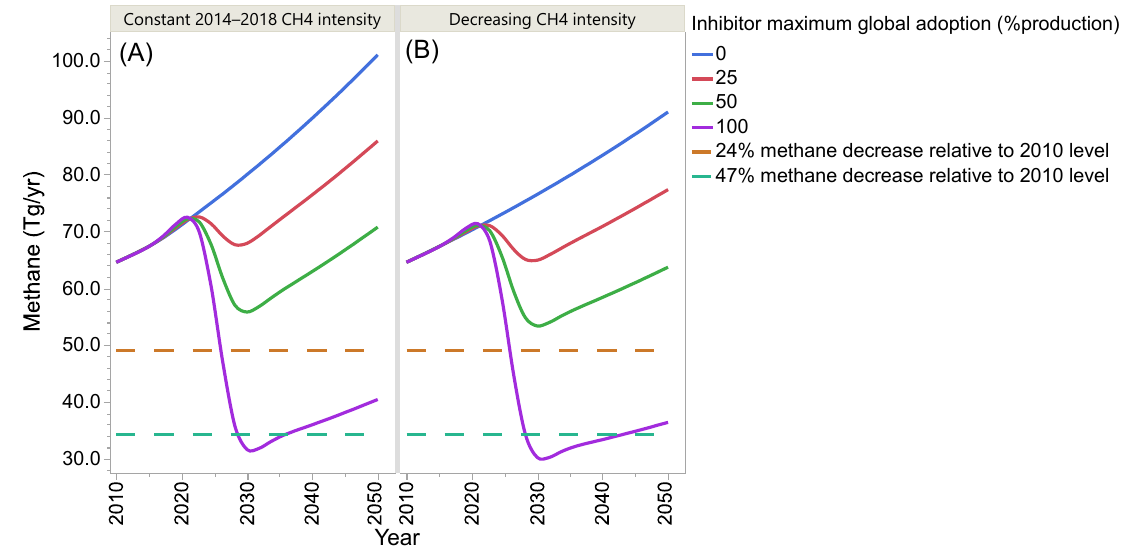
4 ) emissions from global bovine milk produc-